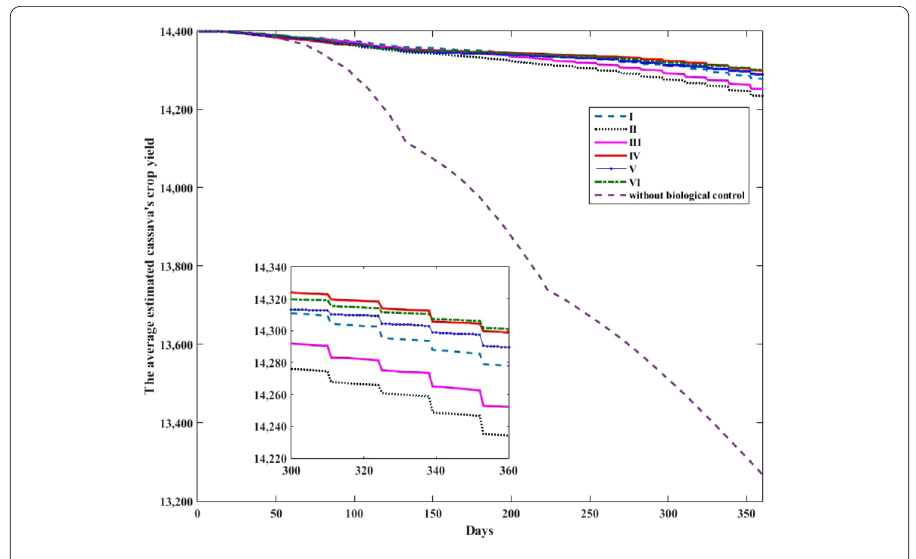
Figure 6 The average estimated cassava crop